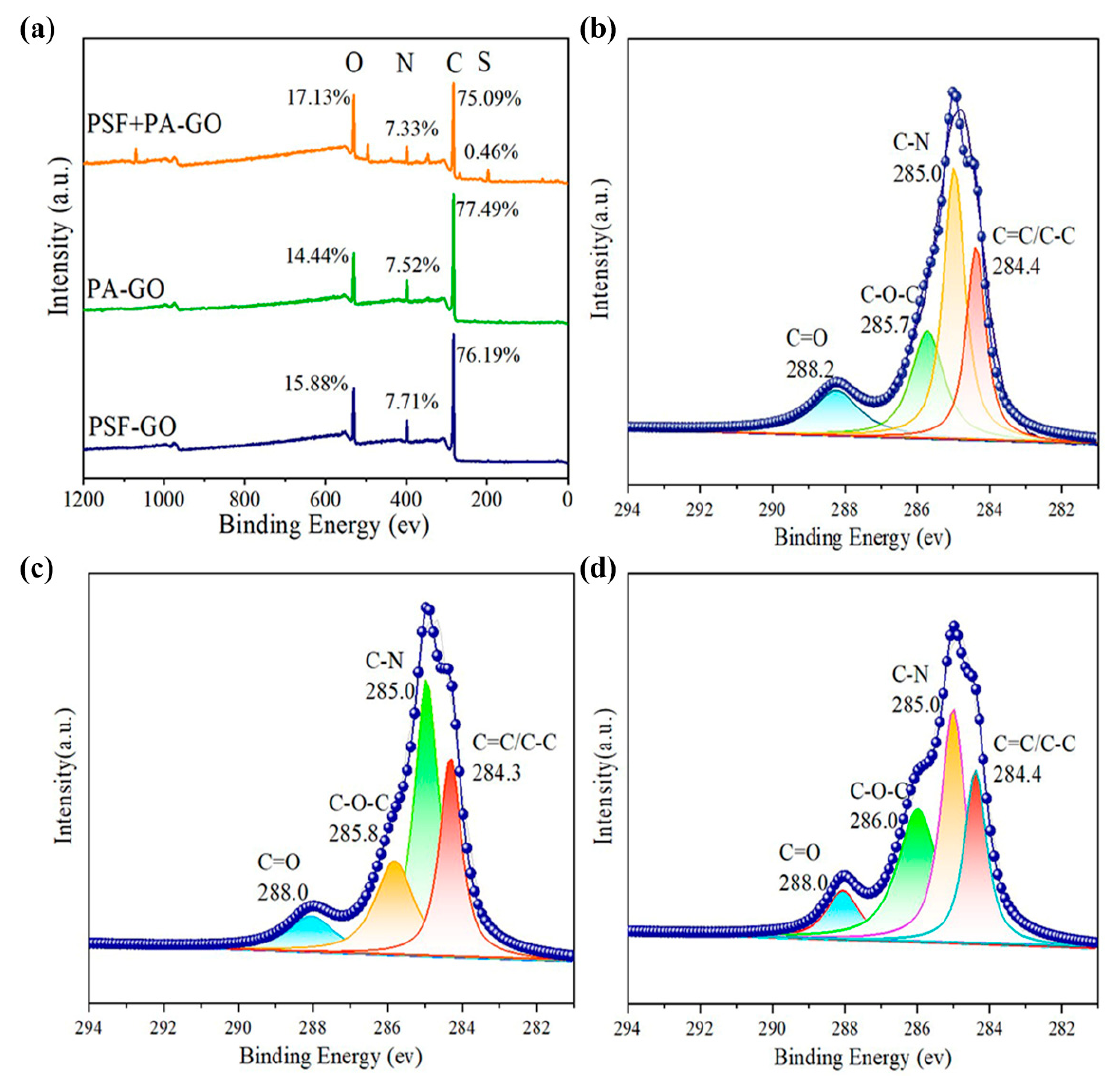
Figure 4. XPS spectra, ( a ) XPS full spectra, ( b – d ) C1s spectra of TFC-FO PSF/GO , TFC-FO PA/GO and TFC-FO PSF-PA/GO membranes.